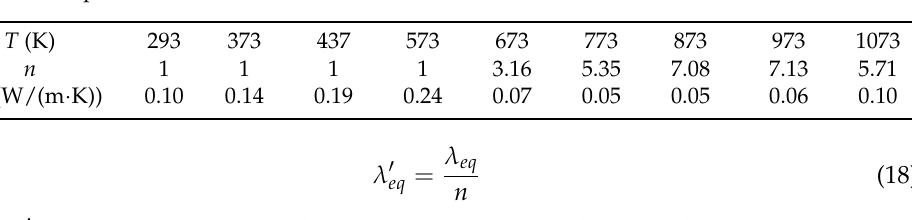
Table 5. The input value in the numerical